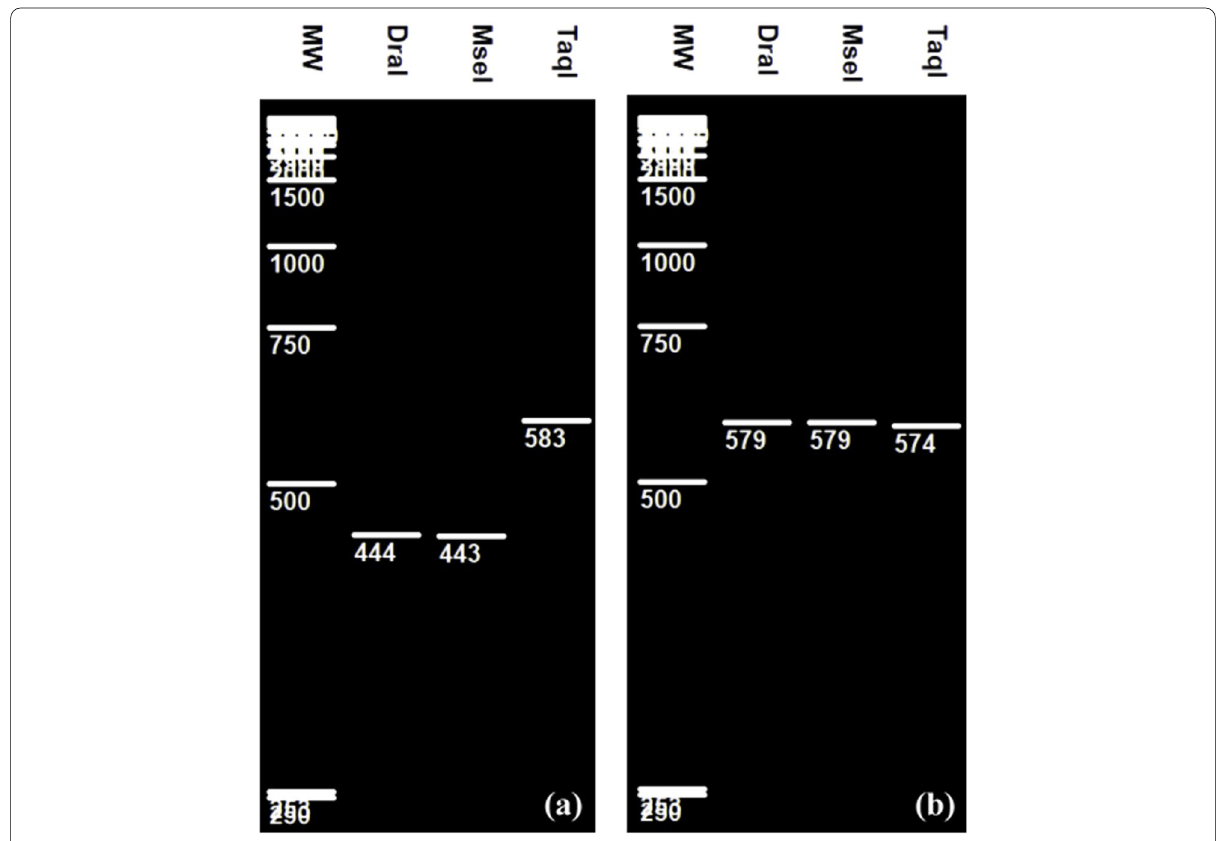
Fig. 4 Virtual RFLP of a L gasseri and b L